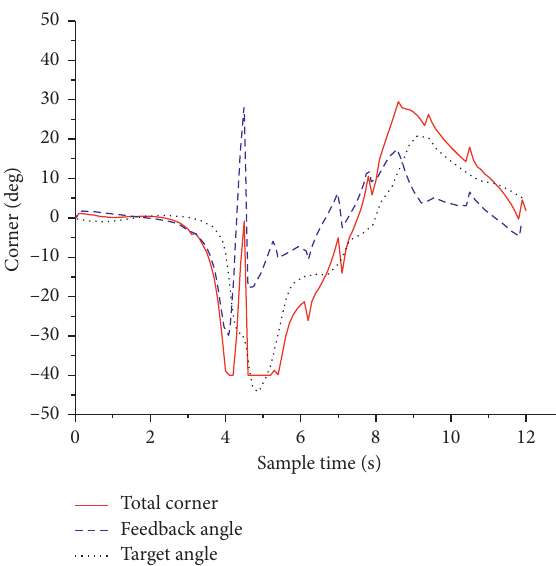
Figure 24: Experimental diagram of steering angle.